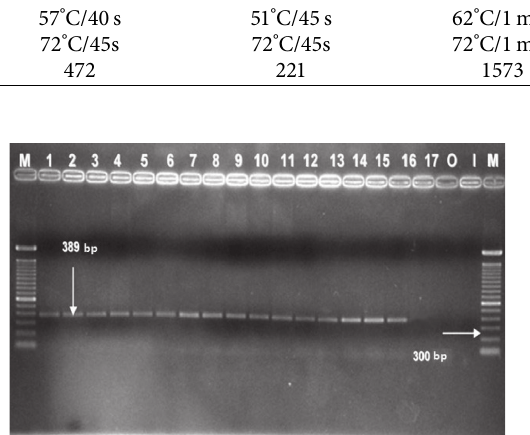
Figure 1: Electrophoresis gel of vmhA gene amplification product. Lanes (M): 100bp molecular weight marker; lanes 1–15: isolated strains of V. mimicus ; lane 16: V. mimicus ATCC 33653; lane 17: Vibrio vulnificus ATCC 29307; lane (O): V. cholerae O1 Ogawa; lane (I): V. cholerae O1